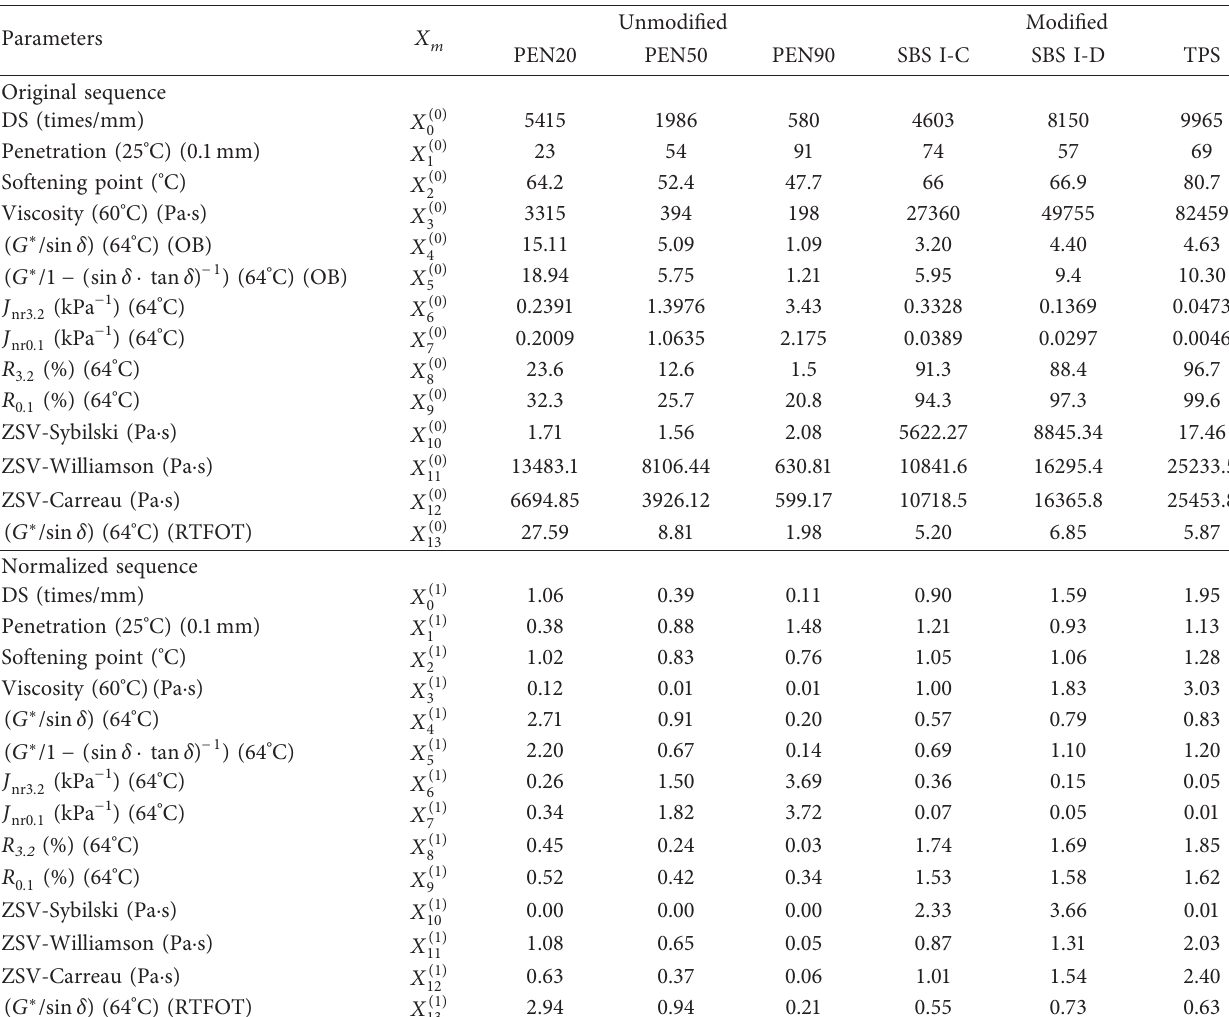
Table 6: Data preprocessing for GRA.